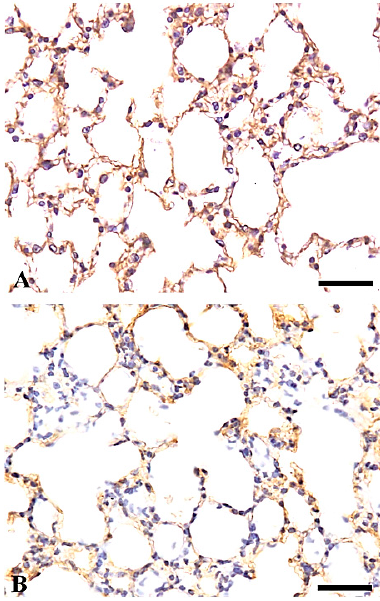
Figure 6. Laminin immunohistochemistry in the lungs of control mice ( A ) and of mice treated with 50 mg/m 3 of the powder for one day ( B ). Positive, continuous, distinct thin lines are shown in the basement membrane of the alveoli ( A ). Weakly positive discontinuous staining is shown in the basement membrane of the alveoli in the inflammatory lesions ( B ). Bars = 30 µm.